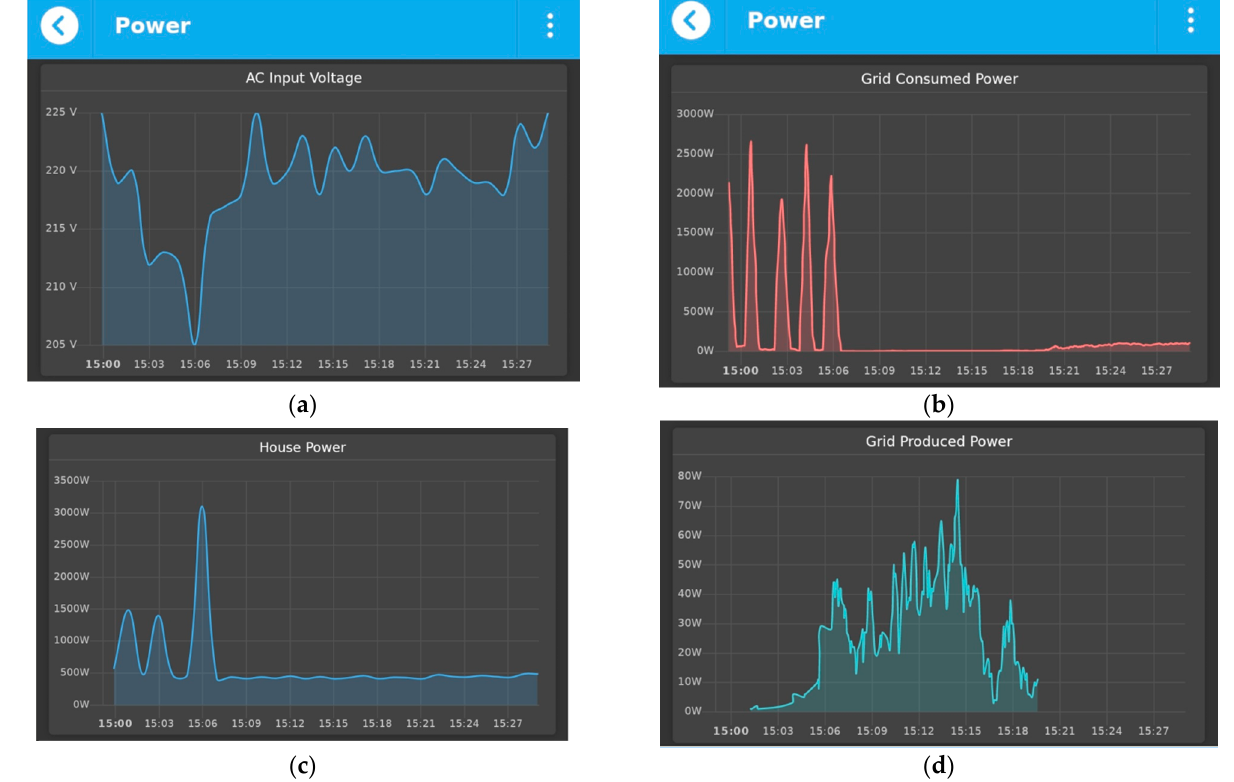
Figure 11. An example of monitoring the power with qToggle: AC Input Voltage ( a ); House Power ( b ); Gris Consumed Power ( c ); Grid Produced Power ( d ).